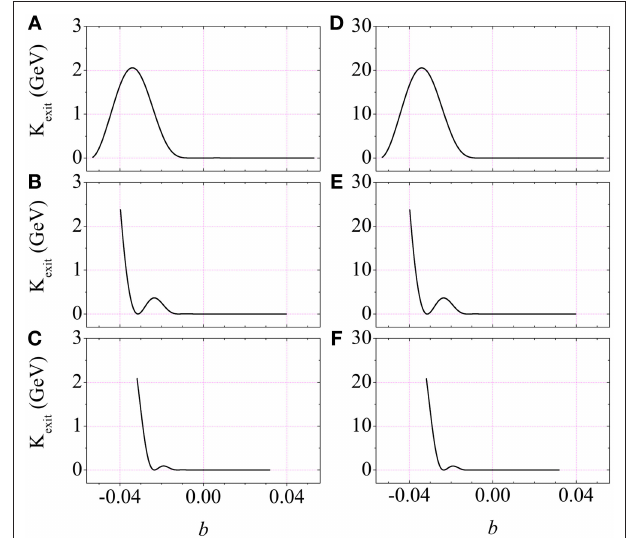
FIGURE 1 | (Color online) (A–C) Exit kinetic energy of a single electron injected axially for interaction with a 10 20 W/cm 2 chirped pulse containing 3, 4, and 5 η -cycles, respectively, vs. the chirp parameter b . The electron is assumed to have been injected axially with kinetic energy K 0 ∼ 2 MeV ( γ 0 = 5) and ϕ 0 = 0. (D–F) Same as (A–C) , respectively, but for pulse peak intensity I 0 = 10 21 W/cm 2 .